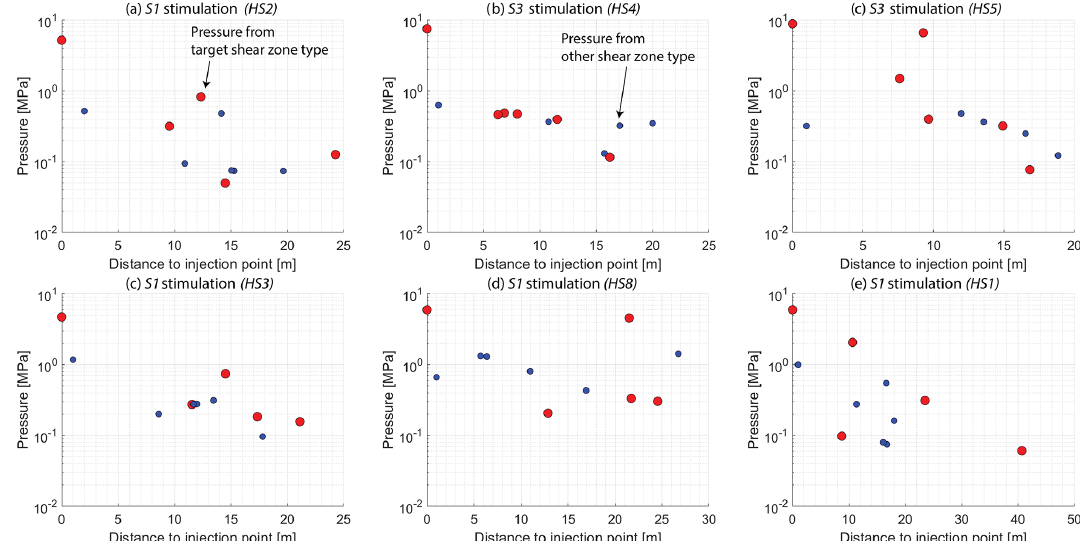
Figure A6. Pressure signals at the moment of shut-in after C3 with respect to radial distance to the injection point.